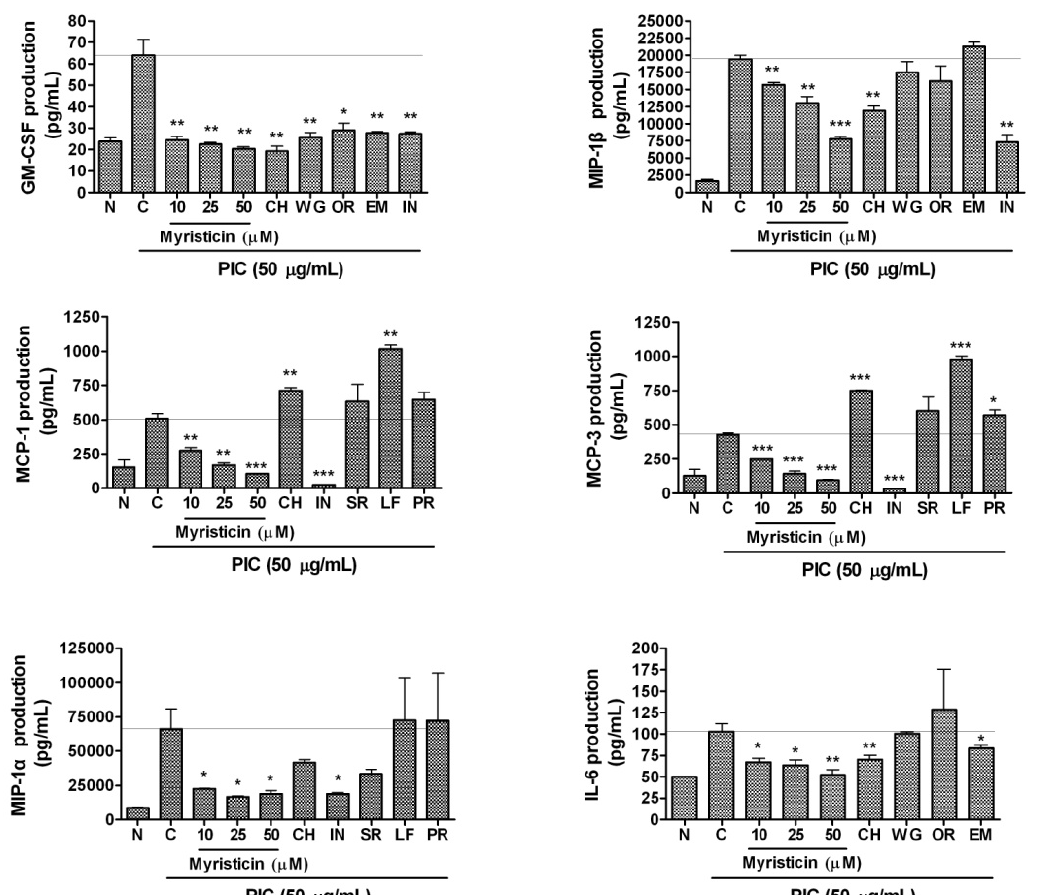
Figure 4. Effects of myristicin on cytokine production (IL-6, IL-10, IP-10,